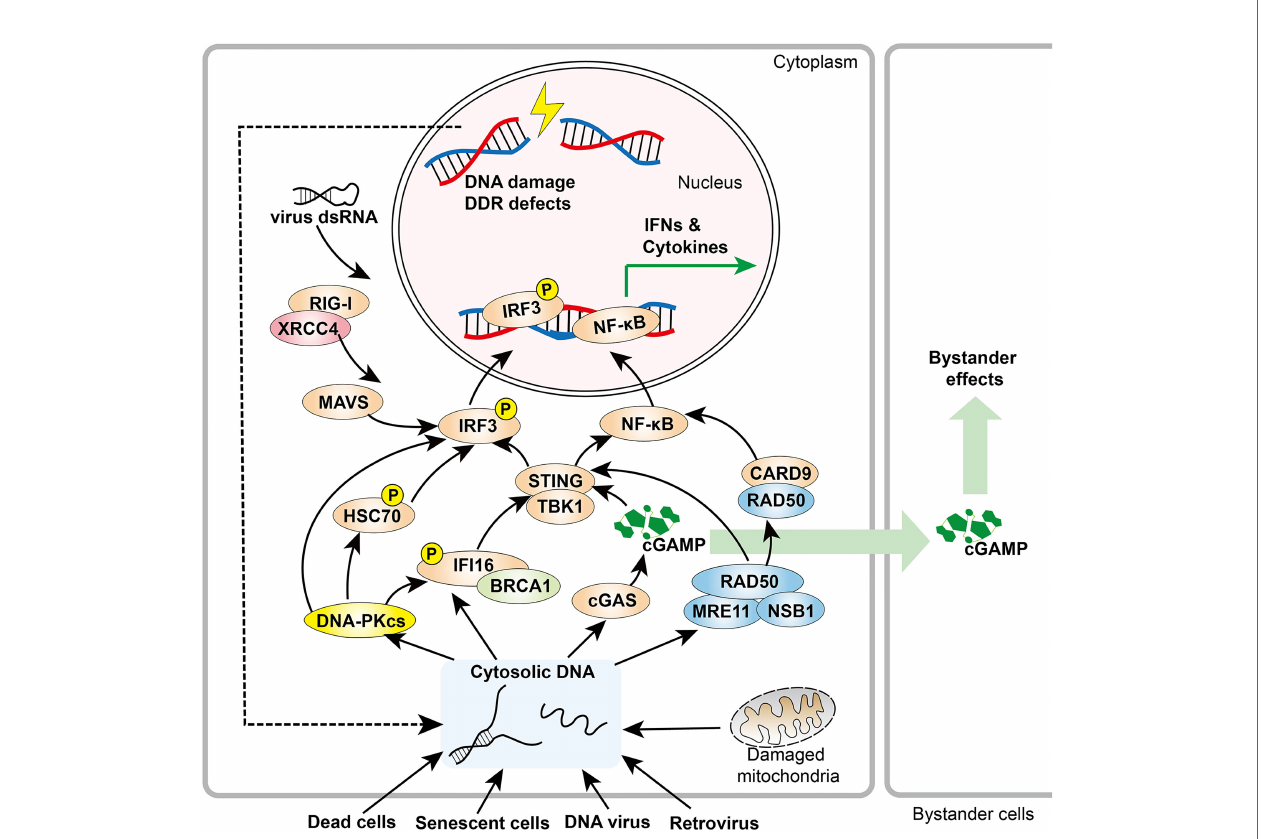
FIGURE 1 | Overview of DDR components in innate immune responses. DDR factors, including DNA-PK and MRE11, promote cytosolic DNA sensing signaling pathways. When activated by cytosolic DNA, cGAS produces cGAMP, a soluble second messenger that initiates STING-IRF3 signaling both within the host cell and adjacent cells. In addition, RAD50 associates with CARD9, leading to NF- k B activation and downstream cytokine production. XRCC4 interacts with RIG-I, which promotes the RIG-I-MAVS-IRF3